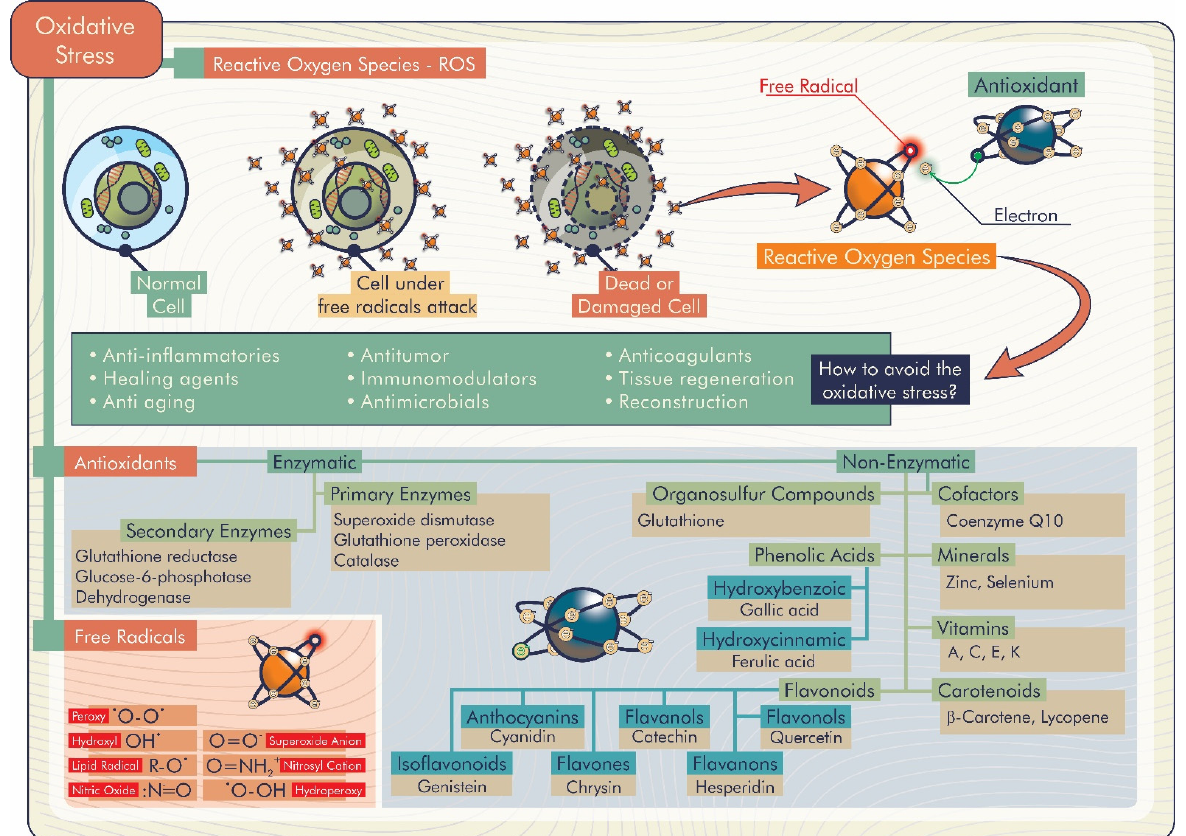
Figure 5. Important biological properties attributed to antioxidant biomaterials.